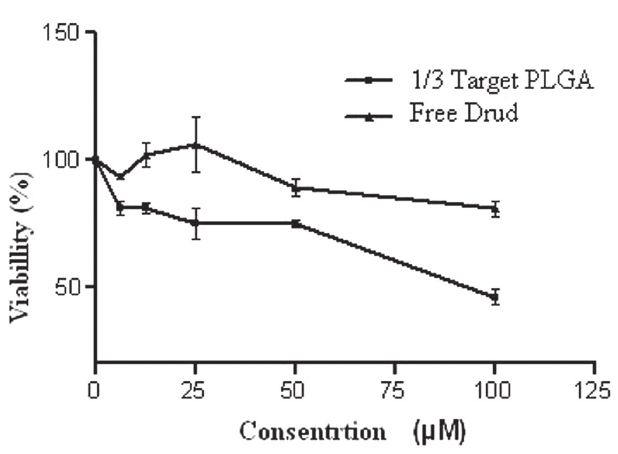
FIGURE 8 - Cell viability of PC-3 cells after treatment with different concentrations ofFL and FLT –loaded PLGA‑PEG‑ Praz. Cell viability measured by MTT assay. IC obtained by plotting thelog10 of the percentage of proliferation values versus drug concentrations. Data areexpressed as the mean ± S.E.M of three separate experiments (n =